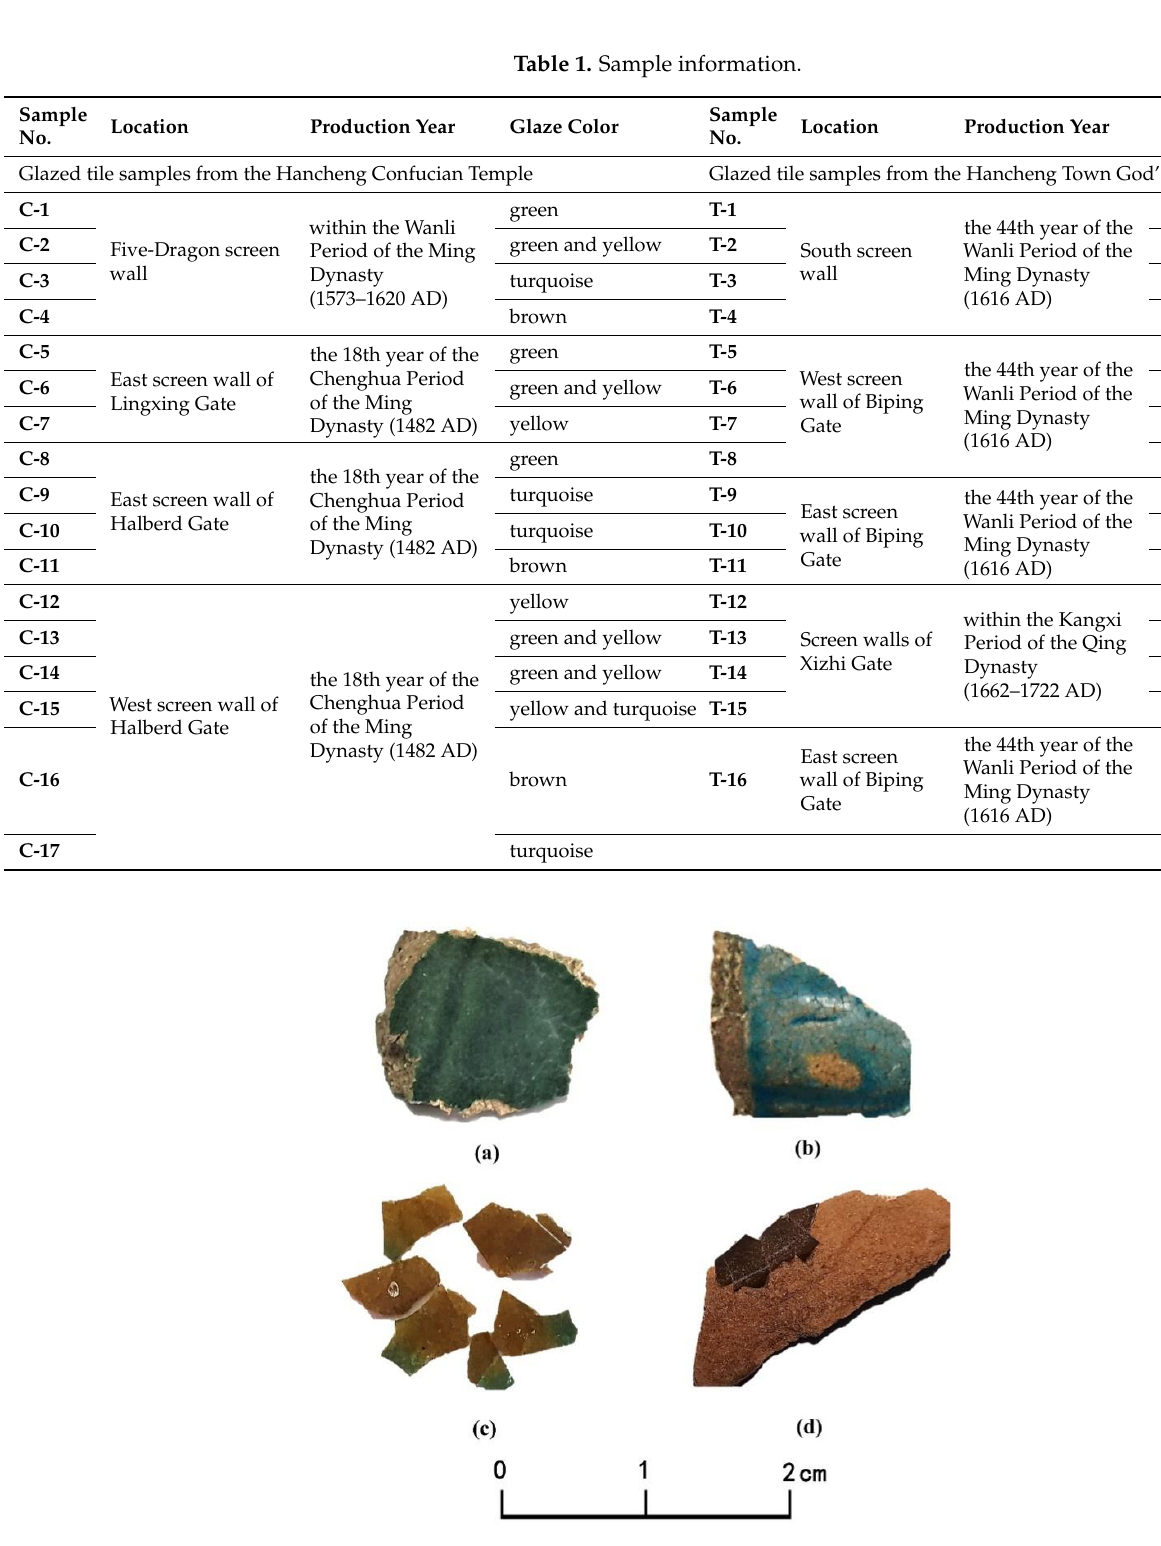
Figure 5. Photographs of the samples representing the four glaze colors in this study. ( a ) Green; ( b ) Turquoise; ( c ). Yellow; ( d ). Brown.